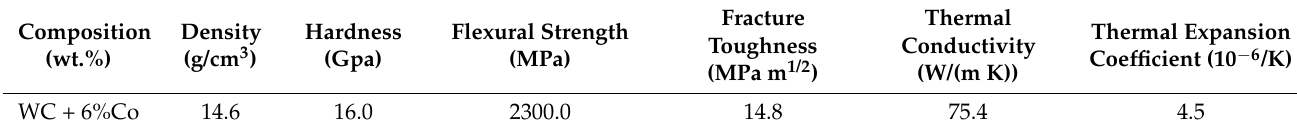
Table 2. The properties of the TiAlN coatings.